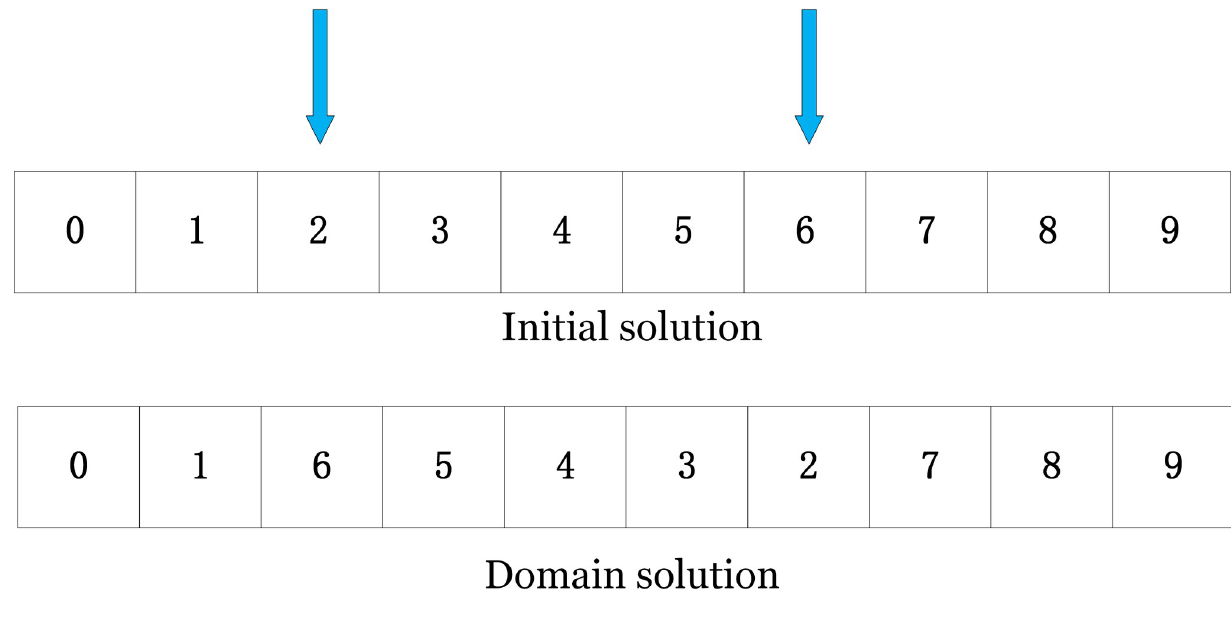
Fig 7. 2-opt example diagram.